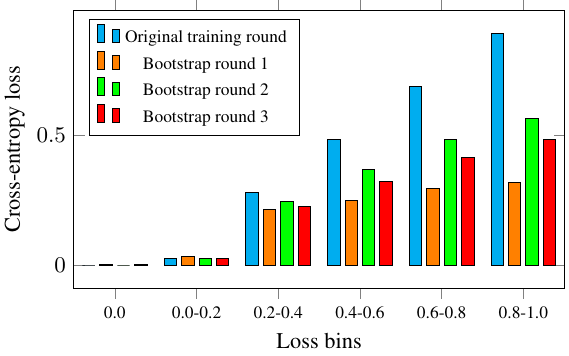
Figure 7. Cross-entropy on the training set at different bootstrap iterations of DenseNet. Samples at each bootstrap round are sorted by their loss in the order of the original training round.